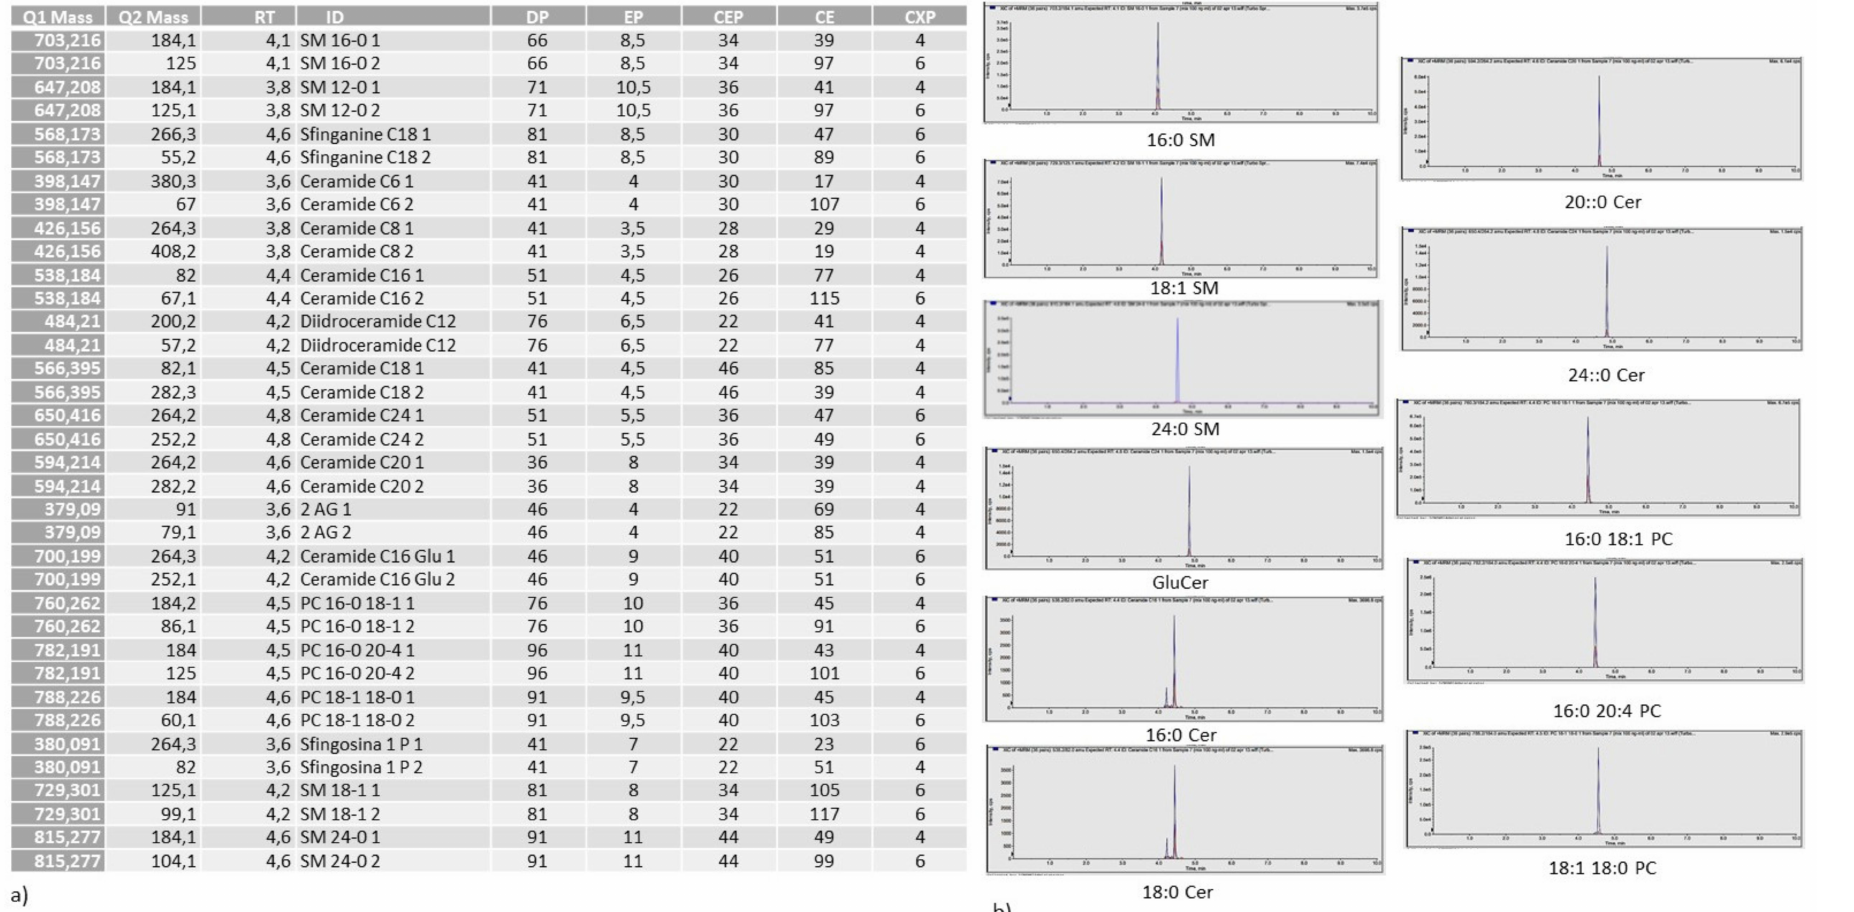
Figure 8. ( a ) Table showing lipidomic data analysis. main transitions decimal (Q1, parent ion; Q2 daughter ions. Retention times (RT); molecule name (ID); declustering potential (DP); entrance potential (EP); collision cell entrance potential (CEP); collision energies (CE); collision cell exit potential (CXP). RT (min); DP, EP, CEP, CE and CXP (V). ( b ) molecules under